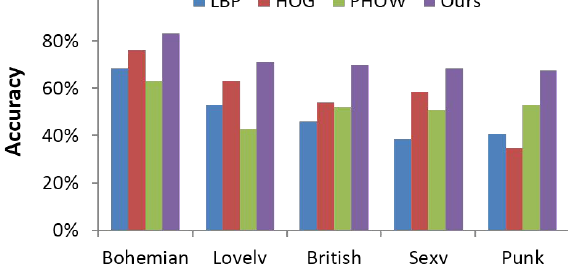
Figure 6: Performance comparison on style